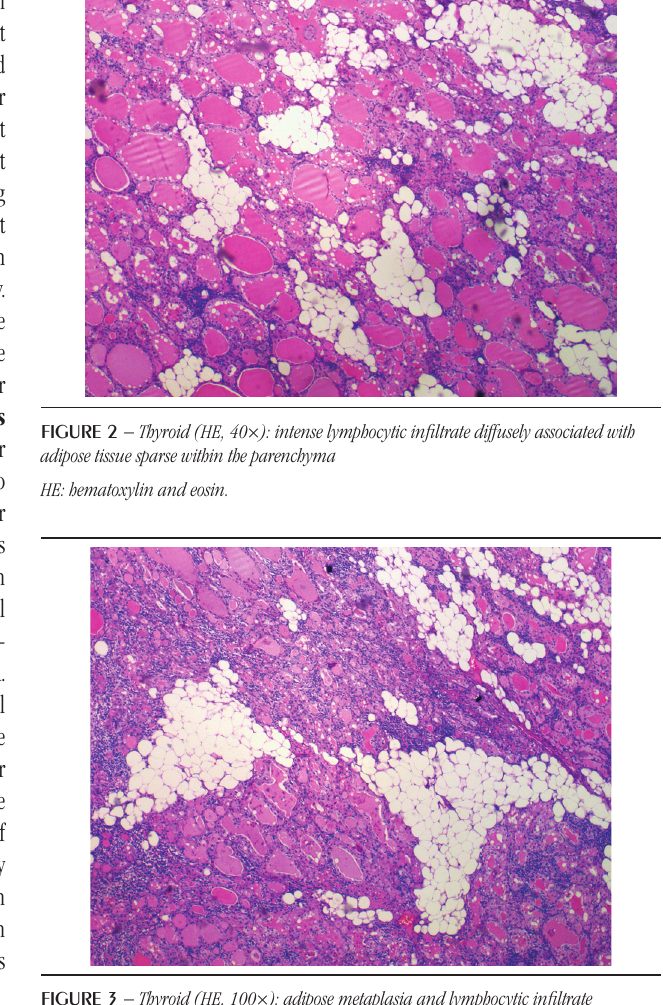
FigurE 3 − Thyroid (HE, 100×): adipose metaplasia and lymphocytic infiltrate HE: hematoxylin and eosin.